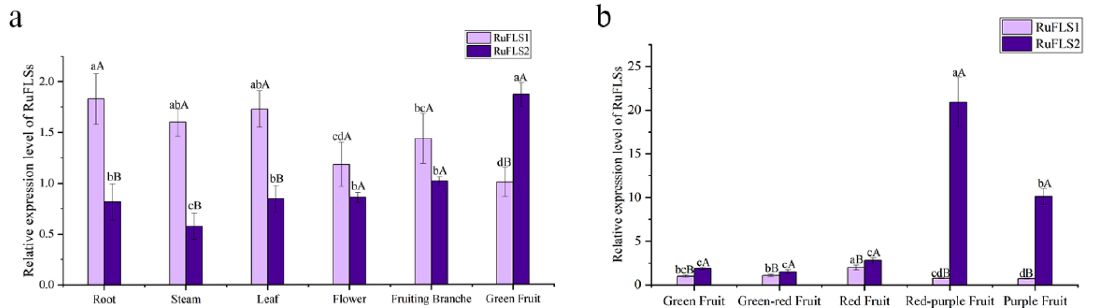
Figure 4. The expression pattern of the RuFLS genes in different tissues ( a ) and different developmen- tal stages of blackberry fruits ( b ). Different lowercase letters indicate significant differences between different harvest periods ( p < 0.05). Different uppercase letters represent significant differences between two RuFLS genes ( p <